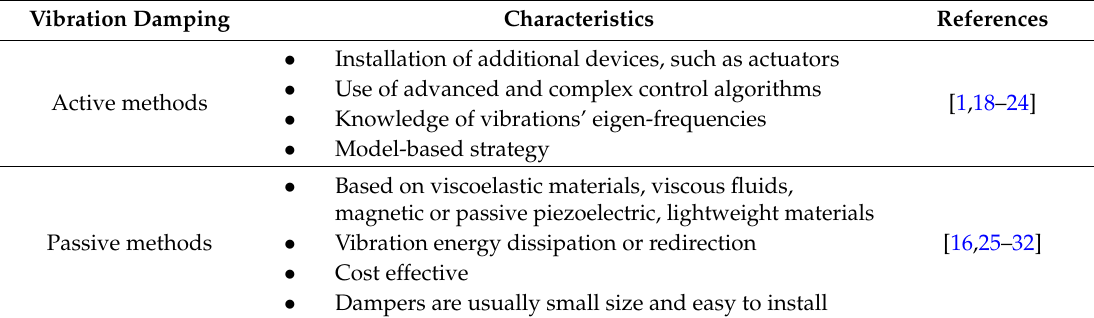
Table 1. Active and passive methods to control and mitigate MT vibrations.